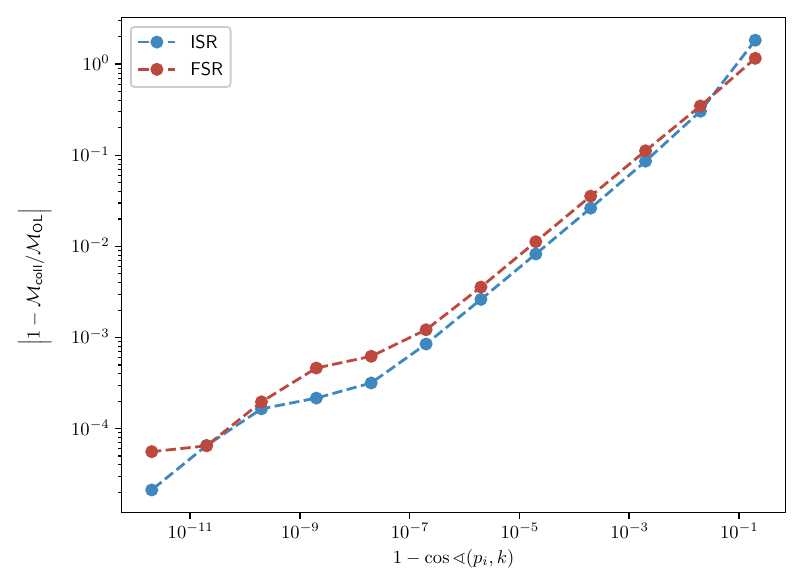
Figure 7 . Convergence of the collinear limit a function of the collinearity. The reference value